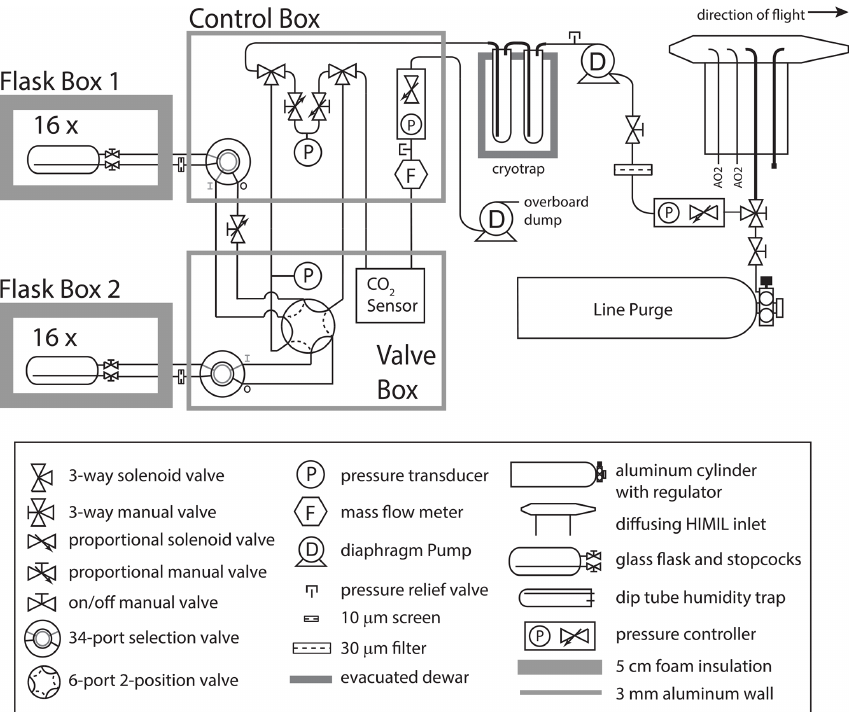
Figure 6. Plumbing diagram of the Medusa flask sampler. Medusa consists of an inlet, a control box, a valve box, two insulated flask boxes, a cryotrap, two pumps, and a purge cylinder. See Sect. 3.1 for a description of the individual components. See Table S1 in the Supplement for selected vendor and part